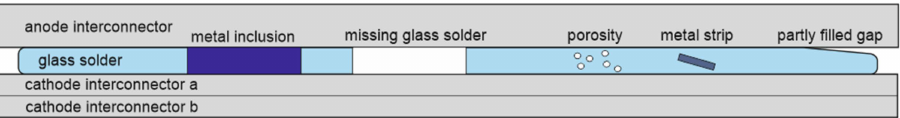
Figure 3. Cross section of the interconnector–glass solder joining region with some types of defects in the glass solder